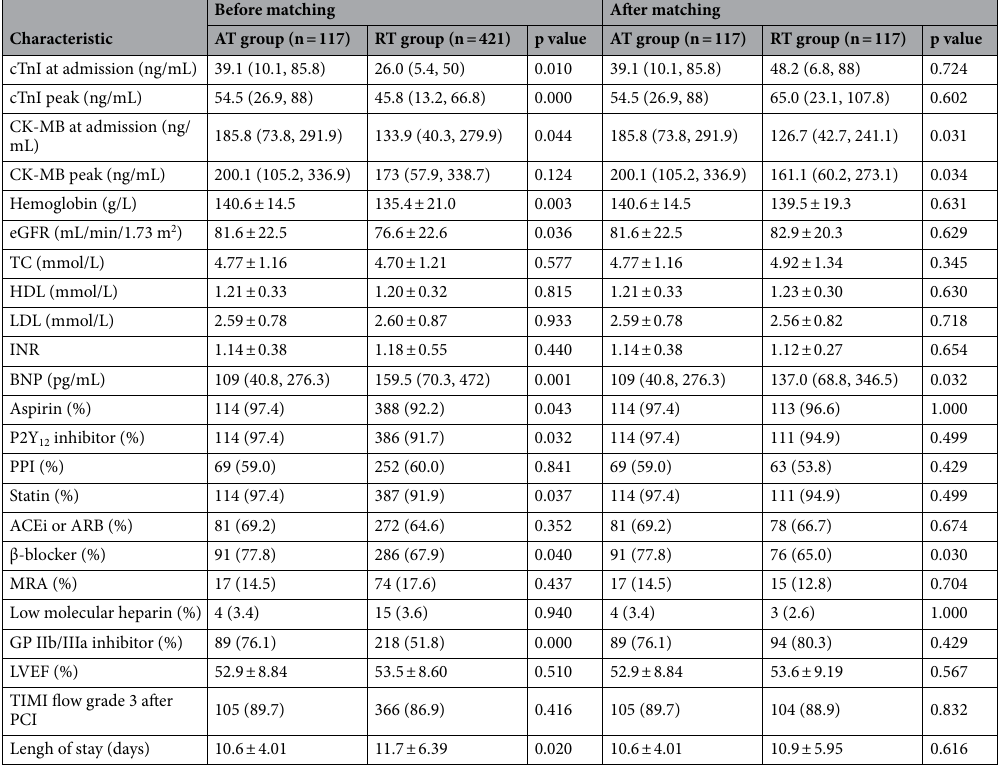
Table 2. In-hospital data before and after Propensity-Score Matching. cTnI cardiac troponin I (reference 0–0.04 ng/mL), CK-MB creatine kinase-MB, eGFR estimated glomerular filtration rate, TC total cholesterol, TG triglyceride, HDL high-density lipoprotein, LDL low-density lipoprotein, INR international normalized ratio, BNP Brain natriuretic peptide, PPI proton pump inhibitor, ACEi angiotensin-converting enzyme